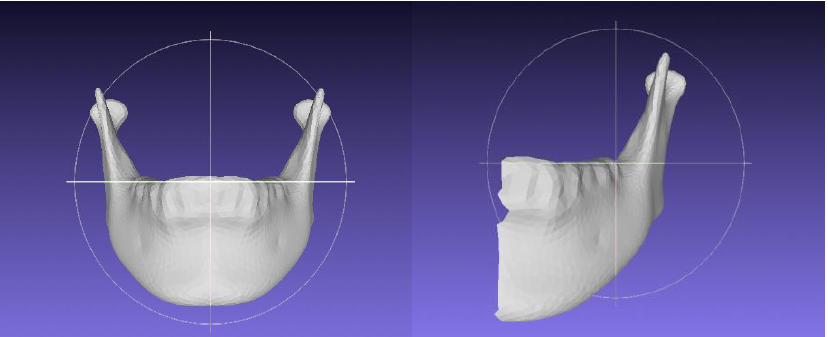
Figure 1. The homologis model of total mandible (left side) and half mandible (right side).